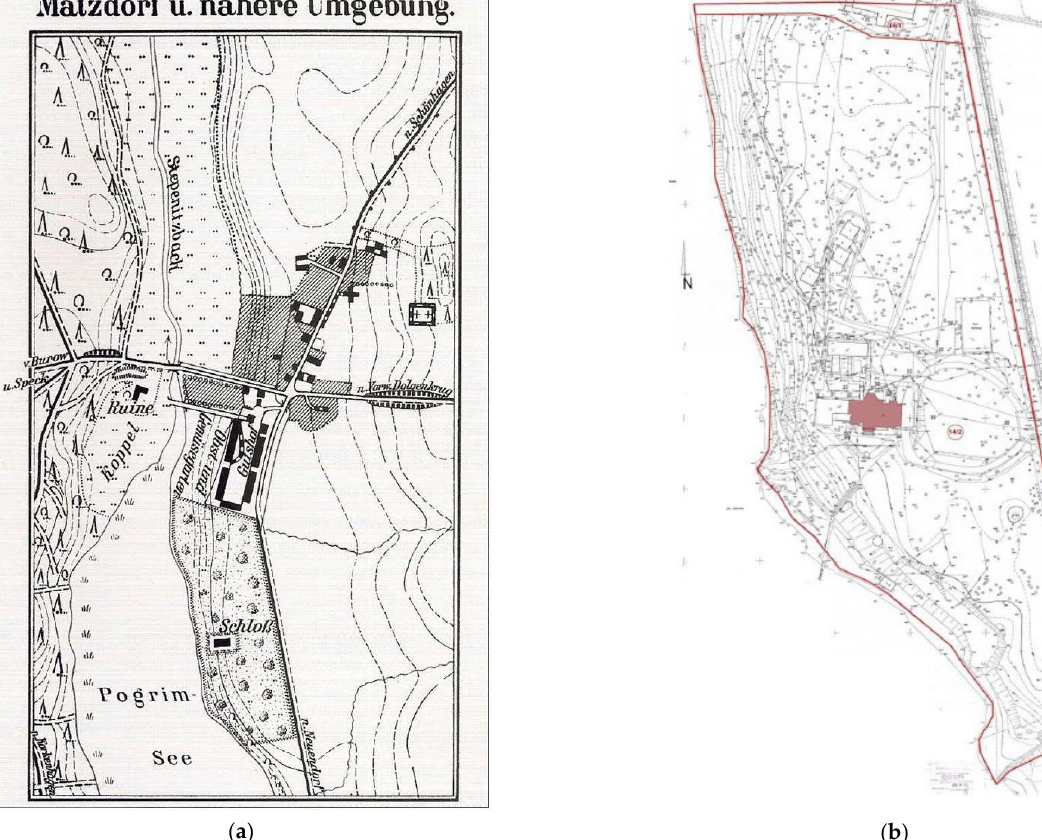
Figure 3. ( a ) Map of the village of Matzdorf (today’s Maciejewo) from the beginning of the twentieth century, with the farm buildings visible on the peninsula on Lake Pogrim (now Lake Lechickie), along with the ruins of the castle and park, and the visible building of the new Palace (Schloss); Archives of WUOZ; ( b ) Plan of the establishment of a park in Maciejewo, specifying the delimitation of the area covered by the decision relating to its entry into the register of monuments; compiled by M. Haas-Nogal.